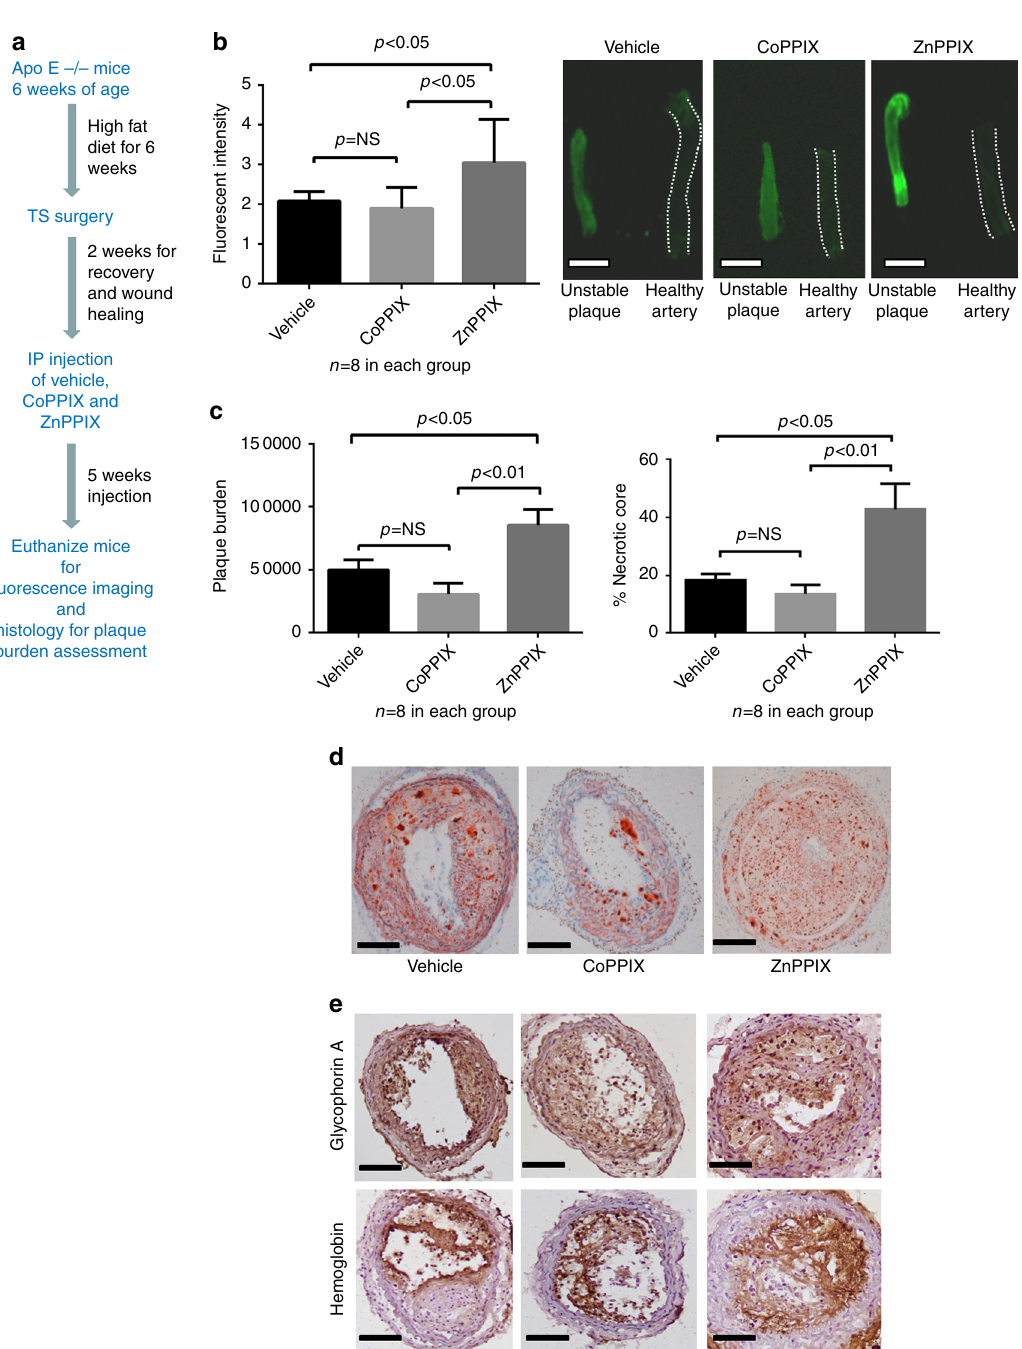
Fig. 7 HO-1 modulation of plaque characteristics in the murine TS model. a The fi gure depicts the summary timeline of the experiment. Tandem stenosis surgery was performed on ApoE-/- mice (6 weeks on western diet at 12 weeks of age). Cobalt protoporphyrin IX (CoPPIX, HO-1 inducer) and Zinc protoporphyrin IX (ZnPPIX, HO-1 inhibitor) were used for HO-1 enzyme modulation. Two weeks after the TS surgery, intraperitoneal injections of ZnPPIX or CoPPIX or the vehicle were performed every second day for 5 weeks ( n = 8 in each group). The mice were killed after 5 weeks of injection for analysis of NIRAF, plaque burden and necrotic core. b Bar graph comparing mean fl uorescence intensity ± SEM of unstable plaque segments in three groups of the TS model (vehicle alone, HO-1 inhibitor ZnPPIX, HO-1 inducer CoPPIX). There was a signi fi cantly higher fl uorescence signal in unstable segments of the ZnPPIX group compared to the vehicle group as well as the CoPPIX group ( p < 0.05, Kruskal – Wallis test followed by Dunn ’ s multiple comparisons test). c Bar graph demonstrating the plaque burden (mean cubic microliter ± SEM; one way ANOVA, left graph) and necrotic core (mean % of lesion area ± SEM; Kruskal – Wallis test followed by Dunn ’ s multiple comparisons test, right graph) in three different groups of the TS mouse model. The plaque burden and necrotic core in the ZnPPIX group were signi fi cantly higher than the other two groups. d Histological sections depicting the representative pictures of three different groups stained with Oil Red O. e Immunohistochemistry staining of glycophorin A and hemoglobin in the unstable plaques from three groups further con fi rmed the presence of red blood cells and hemoglobin. Scale bar indicates 1 mm in b and 100 µ m in d and